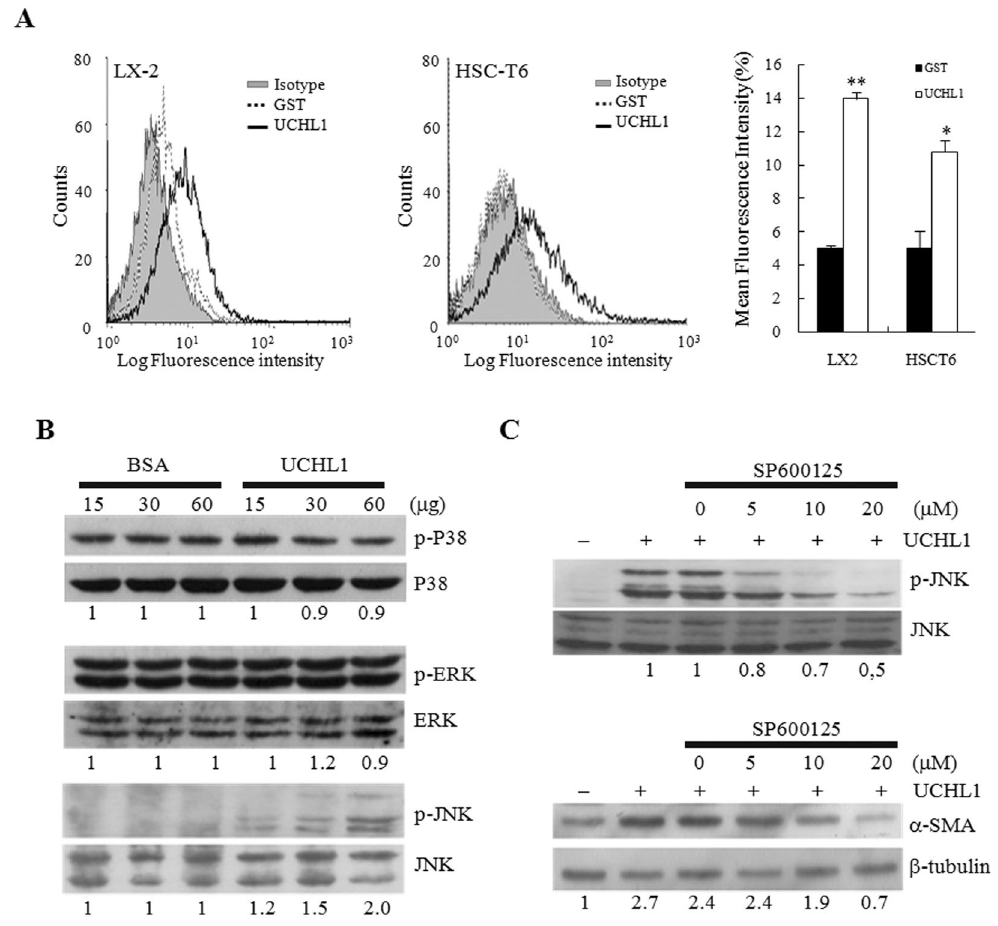
Figure 6. The underlying mechanism of UCHL1-induced HSC activation. ( A ) Purified UCHL1 or GST protein (60 μ g) was preincubated with 1 × 10 6 LX2 (left panel) or HSC-T6 (middle panel) cells, respectively. The binding of these proteins to the membrane surface of the cells was determined by incubation of anti-UCHL1, anti- GST, and isotype control antibodies, respectively, followed by incubation of FITC-conjugated goat anti-mouse secondary antibody and flow cytometric analysis. Purified GST protein was used as a control for non-specific binding. Isotype control IgG was used as the negative control. The mean fluorescence intensity for the indicated protein binding is shown in right panel. ( B ) HSC-T6 cells were treated with increasing concentrations of BSA or purified rUCHL1 protein for 24 h. The expression and the phosphorylation status of p38, ERK and JNK were analyzed by Western blotting. ( C ) HSC-T6 cells were treated with the indicated concentrations of the JNK inhibitor SP600125 for 30 min in DMEM supplemented with 0.2% FBS. Purified rUCHL1 (60 μ g) protein was then added into the culture medium for 1 h to analyze the phosphorylation status of JNK and for 24 h to determine the expression of α -SMA. The expression of β -tubulin was used as the control for equal protein loading. The number below the gel images represents the relative α -SMA expression levels after normalization with the expression of β -tubulin. The full Western blot and the corresponding positions of the molecular weight protein markers are presented in Supplementary Fig.